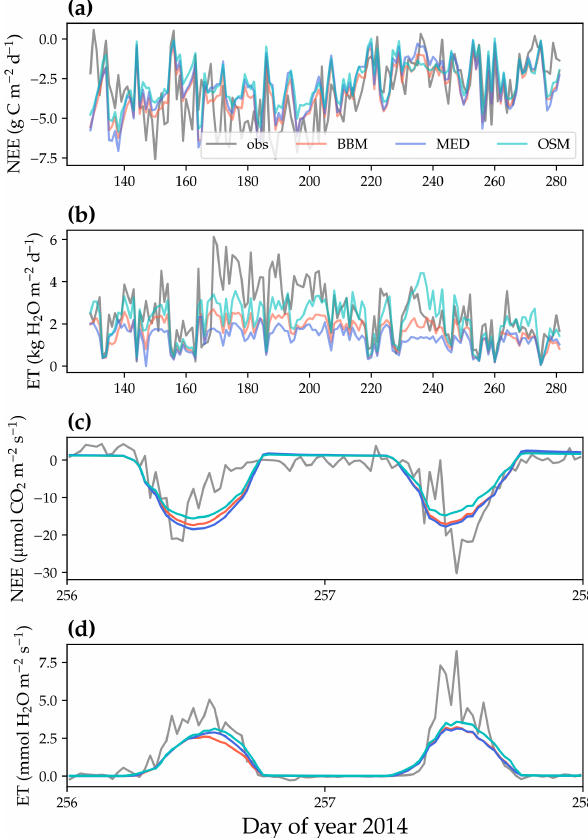
Figure 8. Comparison of model-predicted carbon/water fluxes to the US-NR1 (Niwot Ridge, evergreen gymnosperm forest) flux tower – observations for the year 2014. (a) The gray curve plots the daily CO 2 flux in the growing season. The shaded red, blue, and cyan curves plot the respective Ball et al. (1987), Medlyn et al. (2011), and Wang et al. (2020) stomatal model predictions (BBM, MED, and OSM, respectively). (b) Comparison of modeled and ob- served daily total transpiration flux. (c) Comparison of half-hourly modeled and observed net ecosystem carbon flux (NEE) for days 256–257 of the year 2014. (d) Comparison of modeled and observed ecosystem water flux (ET) for days 256–257 of the year 2014.